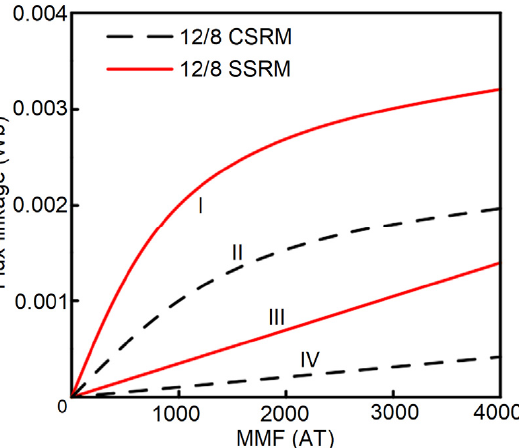
Figure 3. The Flux/MMF characteristics comparison. Notes: “I” and “II” is the aligned position’s curve; “III” and “IV” is the unaligned position’s curve between 12/8 CSRM and segmental rotor SRM.